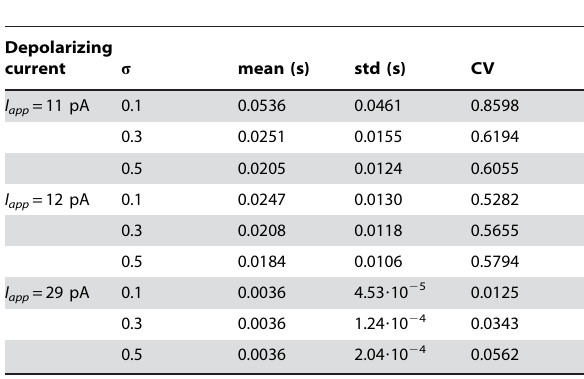
Table 3 . Quantitative analysis of the interspike intervals of the stochastic